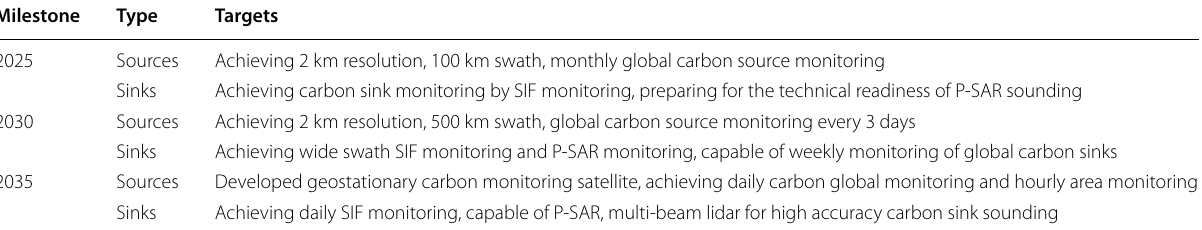
Table 5 Development roadmap of carbon monitoring system